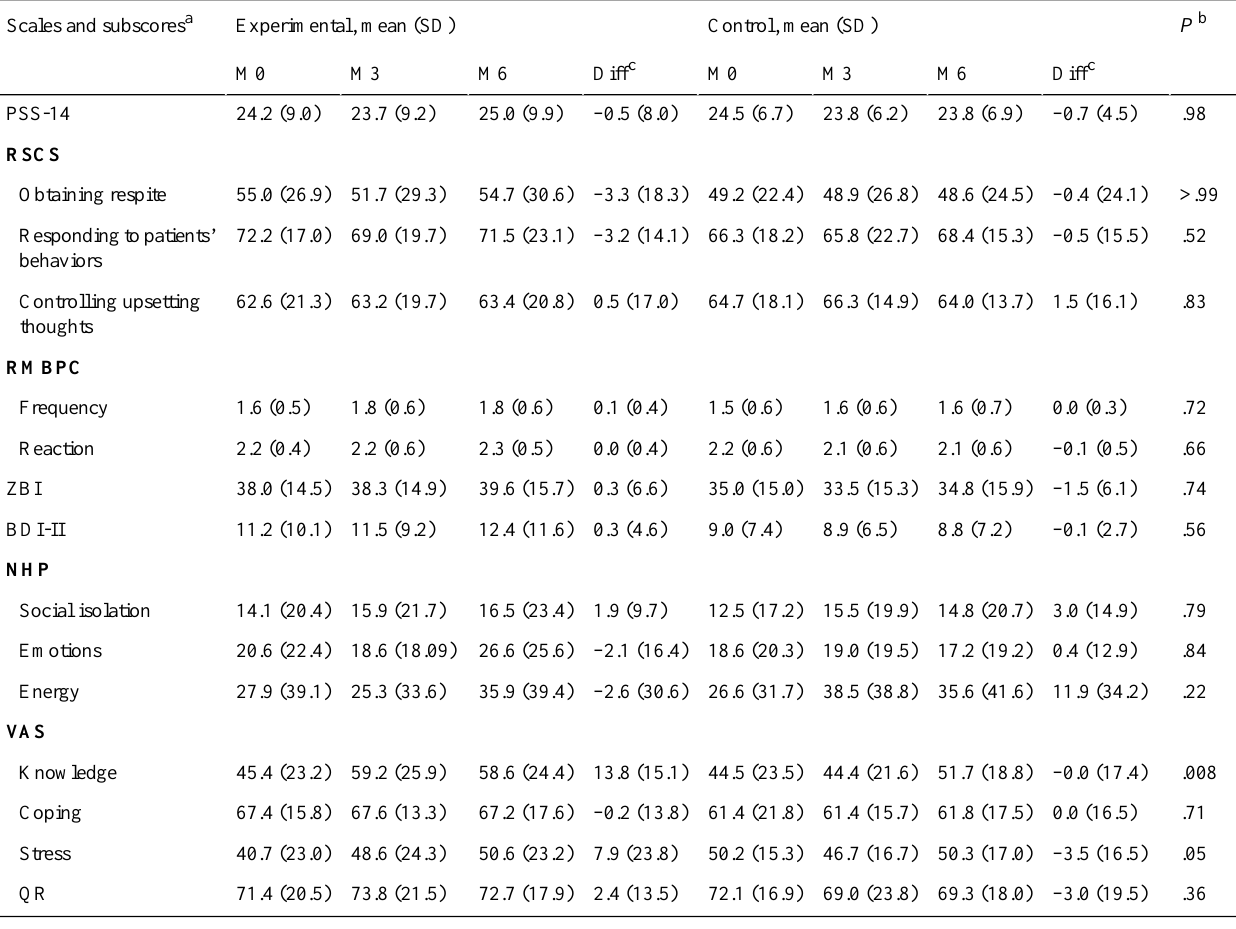
Table 2. Outcome measures (means and SDs) for assessments at baseline (M0), after intervention (M3), and at 6-month follow-up (M6) per group.